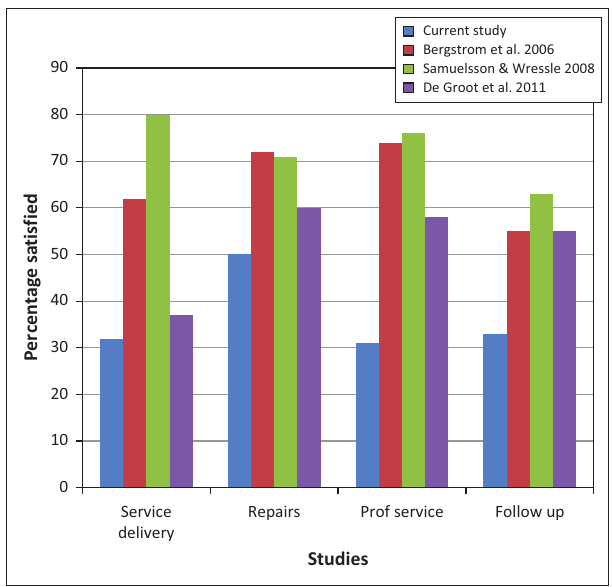
FIGURE 8: Comparison of QUEST 2.0 wheelchair services item scores across four